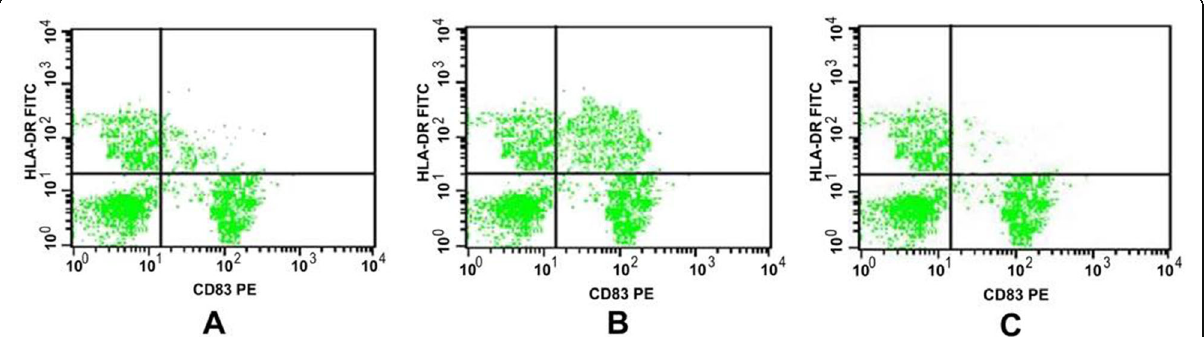
Fig. 2 The expression of CD83 PE (lower right) and HLA-DR FITC (upper left) on dendritic cells by flow cytometry; dendritic cells (gated